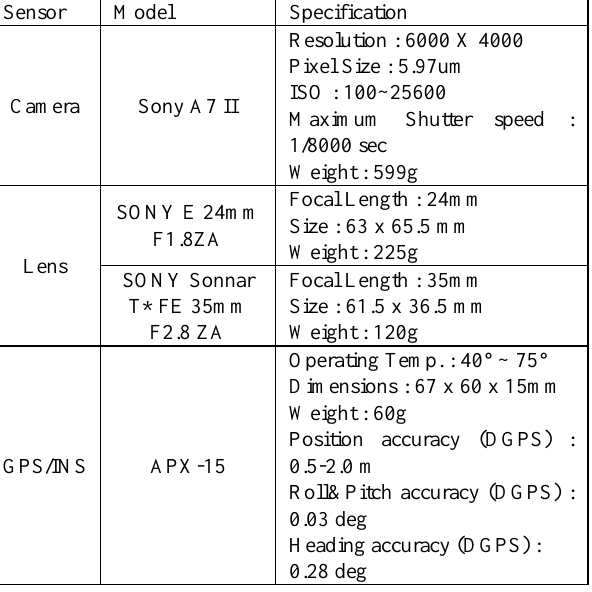
Table 1. Model and main specifications of the sensors